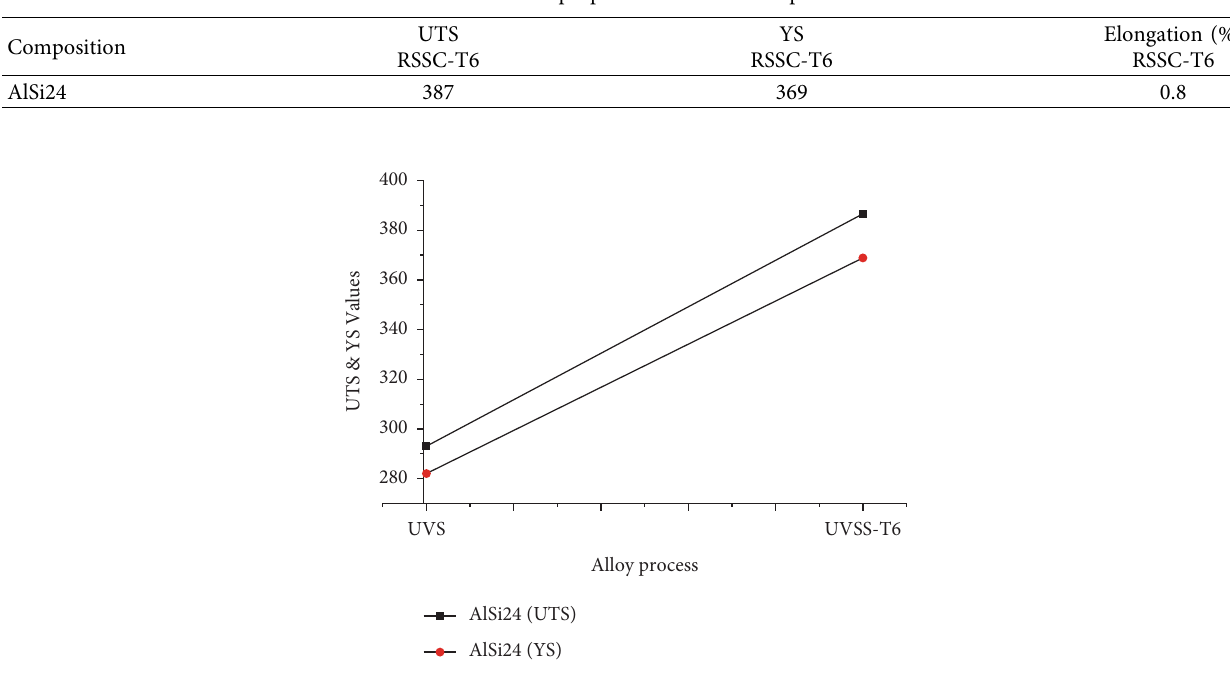
Figure 7: Hardness values of AlSi24 alloy. Table 6: Tensile properties of AlSi24 composite.